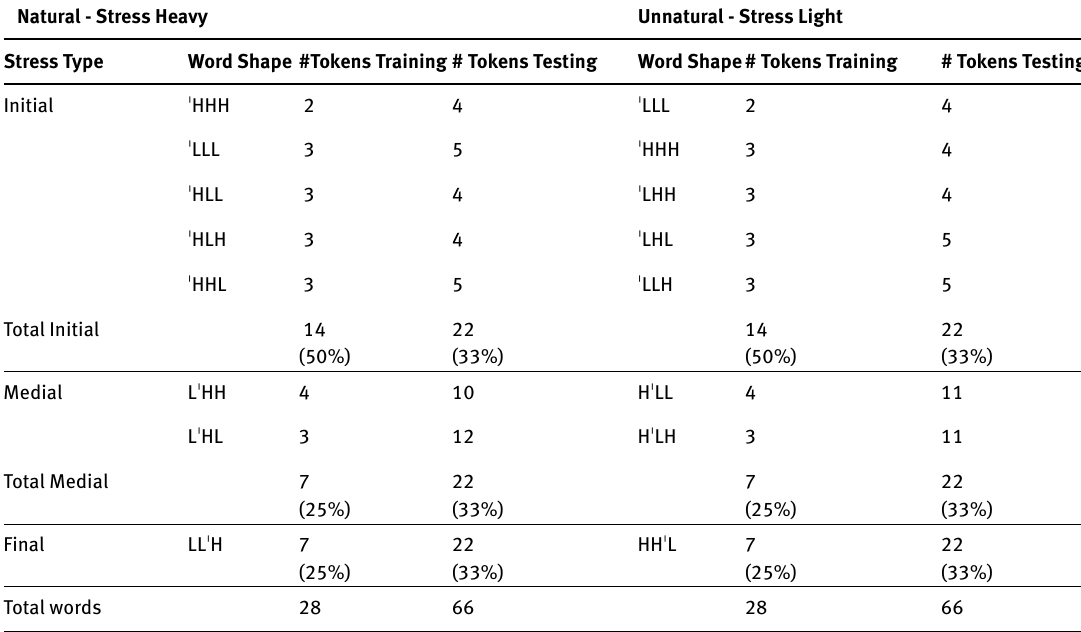
Table 3 Distribution of word shapes and stress patterns Natural - Stress Heavy Unnatural - Stress Light Stress